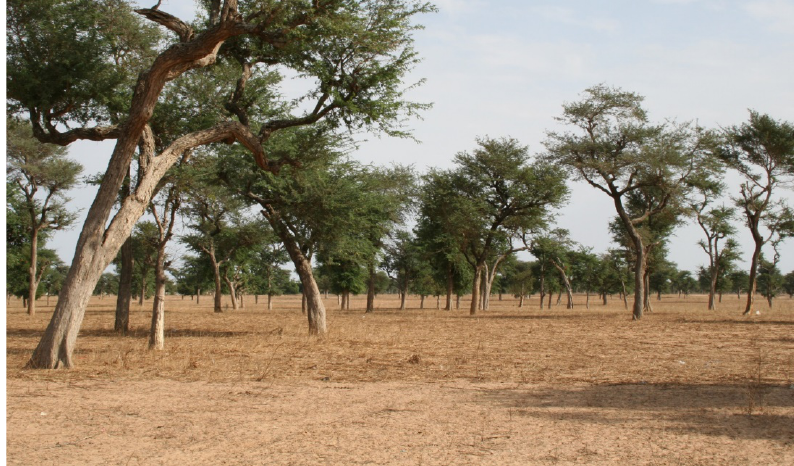
Figure 2. Agricultural parkland landscape with a field tree canopy cover of 5–8% in the administrative region of Thies, January 2011. The Faidherbia albida trees are in full leaf, whereas the ground is bare of photosynthetically active herbaceous or crop cover in this season, which facilitates extraction of tree cover from remote sensing data (Photo: Gray Tappan,